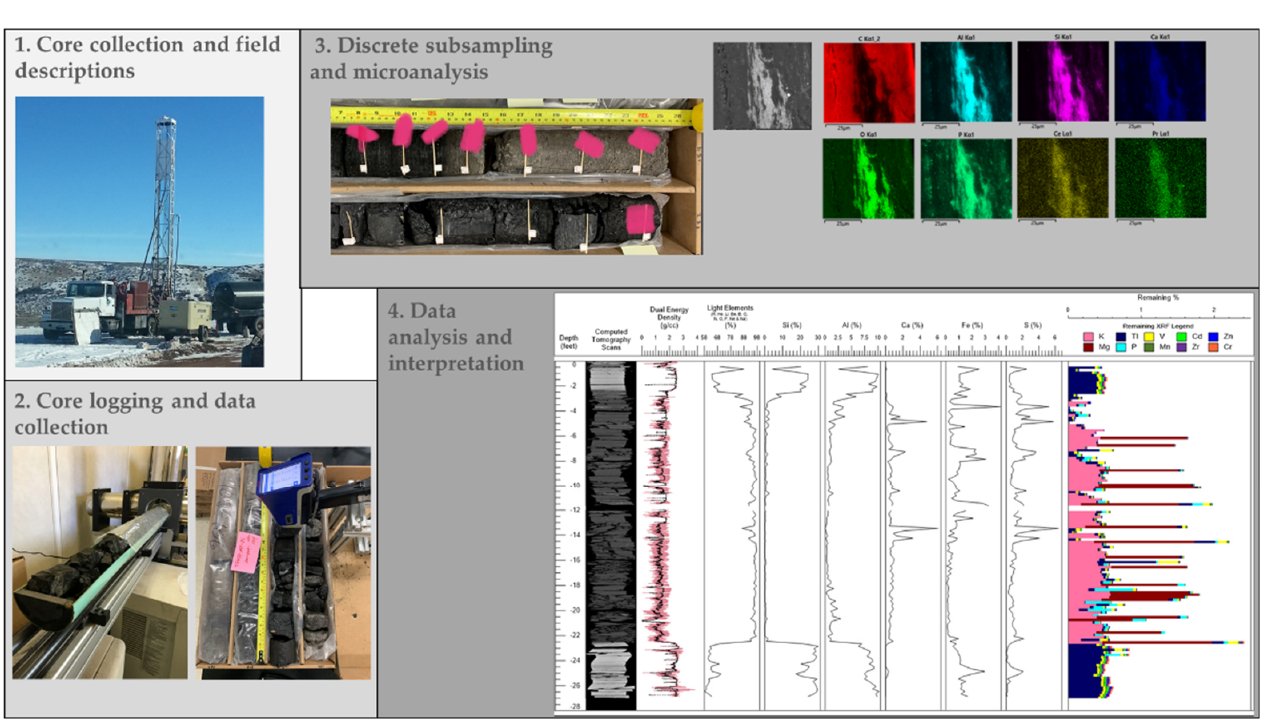
Figure 1. Core characterization workflow steps and methods for collection and analysis of data from sedimentary rock cores. 1. Core collection at Brook Mine, Sheridan Wyoming. 2. MSIL core logging and pXRF analysis of cores in the NETL laboratory. 3. SEM imaging and EDS mapping of elements. 4. Compiled core log detailing the Mining-plus suite elemental results; (from left to right) CT images, dual energy density, mean density (black), standard error (red) (gm/cc), light elements (up to silicon) (LE) (%), silicon (Si) (%), aluminum (Al) (%), iron (Fe) (%), calcium (Ca) (%), sulfur (S) (%), remaining elements